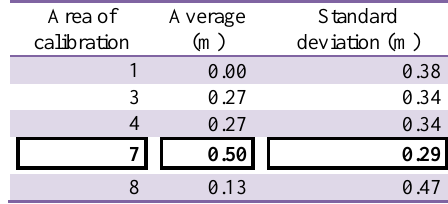
Table 5: Averages and standard deviations of the differences between the points of the DSBM and those of the NRTK survey